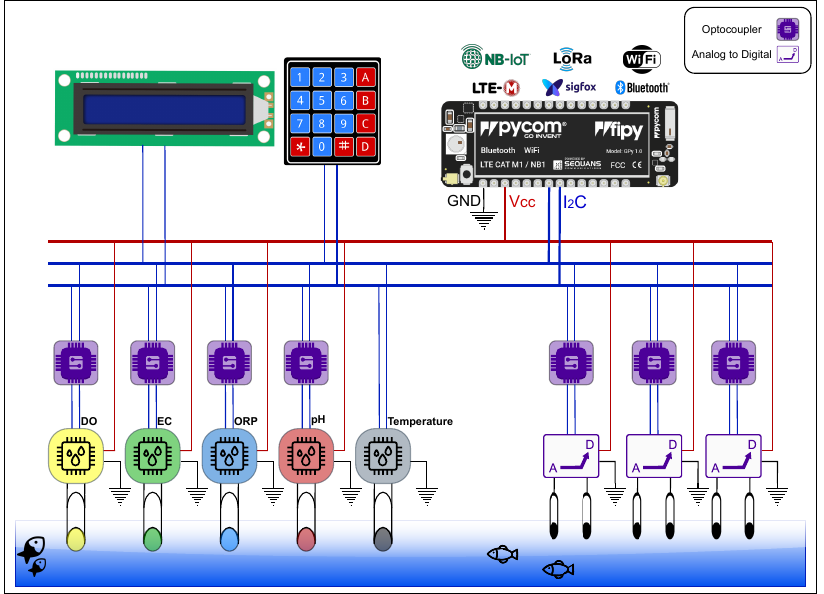
Figure 4. Overview Design of WaterMon System.